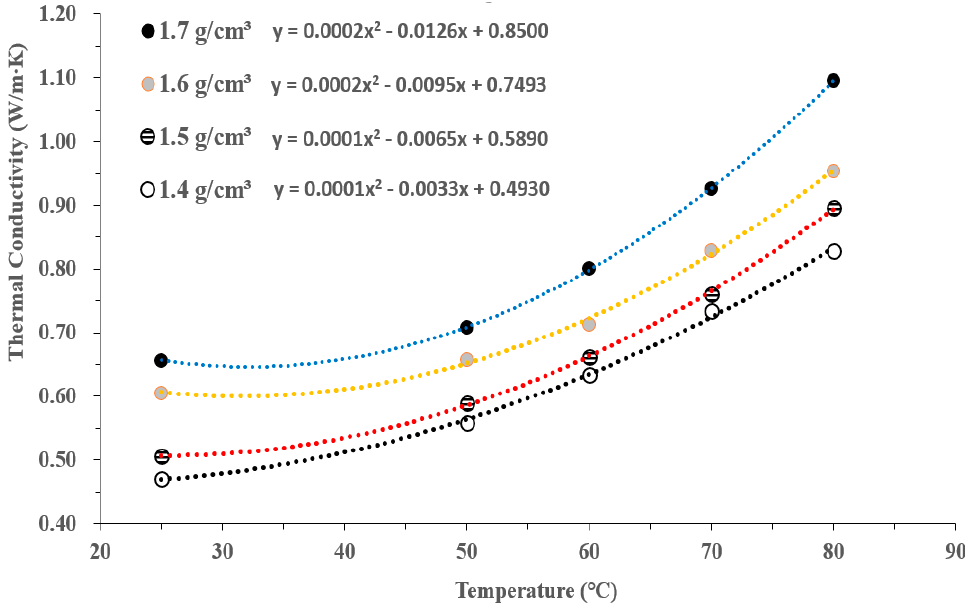
Figure 10. Thermal conductivity vs. temperatures based on the NP method.